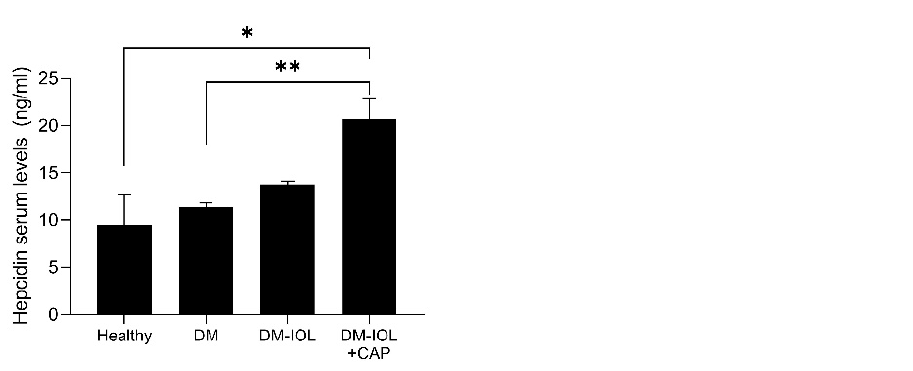
4 of 10 row ) Iron deposits detected with stain (arrows) in kidney tissues from ( a ) healthy rats; ( b ) in rats with diabetes (DM) only; ( c ) in DM with IOL (DM-IOL); and ( d ) in DM with IOL + CAP (DM-IOL + CAP); ( e ) Areas of iron deposits measured in kidneys from each group with Perls’ Prussian blue staining; ( f ) Total iron content in kidneys. Images were acquired at 40× with Axio Vision v.4.8. Scale bars: 20 μ m. Graphs show the mean ± standard error. * p < 0.05, ANOVA and post-hoc Bonferroni